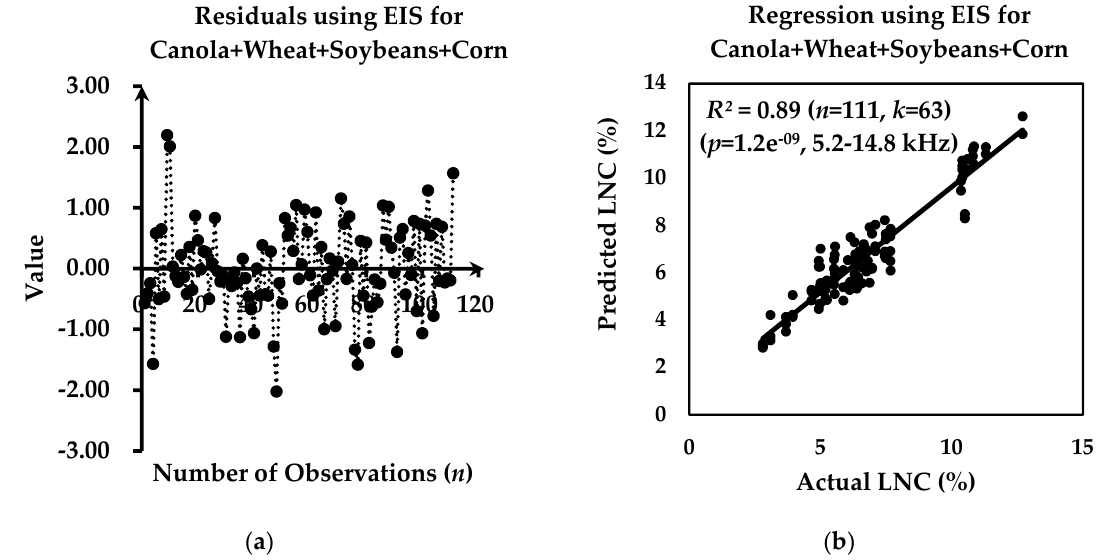
Figure 6. Plots of ( a ) number of observations versus value of residuals; and ( b ) actual versus predicted LNC for canola + wheat + soybeans + corn using EIS. The extracted coefficient of determination ( R 2 ) is 0.89 and the corresponding overall correlation coefficient ( R ) is 0.94.